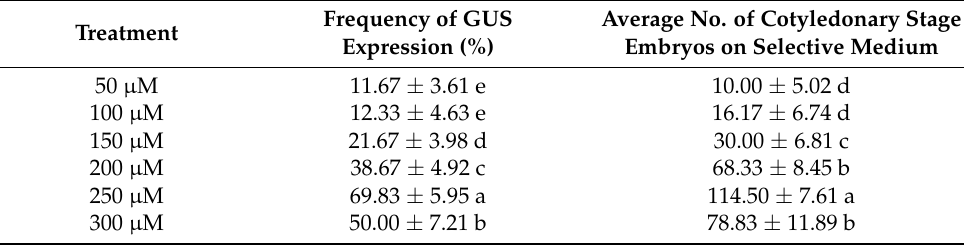
Figure 2. Stable expression of GUS in FECs ( A ) and GFP in cotyledons ( B ) under different concentrations of acetosyringone. ( A ) GUS staining of FECs. FECs were taken from the last time on GD medium plates. After GUS staining, pictures were taken under an ultradeep field microscope. ( B ) Cotyledons on MSN medium under white light and fluorescence. Red arrows point to somatic embryos with green fluorescence. Table 2. Effects of AS concentration on cassava SC8 transformation.